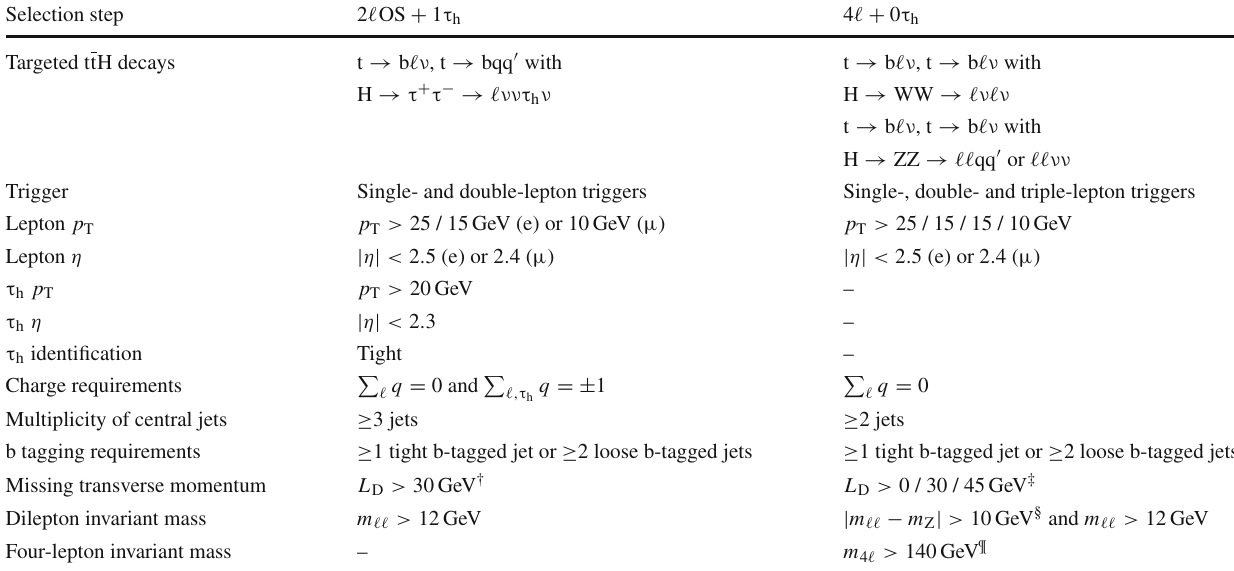
Table 4 Event selections applied in the 2 (cid:4) OS + 1 τ h and 4 (cid:4) + 0 τ h channels. The symbol “–” indicates that no requirement is applied Selection step